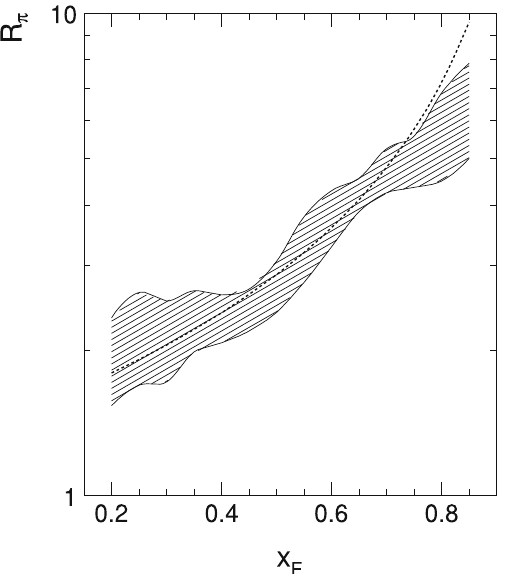
Fig. 90 R parton as a function of x F (dotted line). R parton is adjusted to the mean p T at x F = 0.2. The shaded area gives the limits of the experimental R π ratio presented in Fig. 89 between p T = 0.05 and 0.6